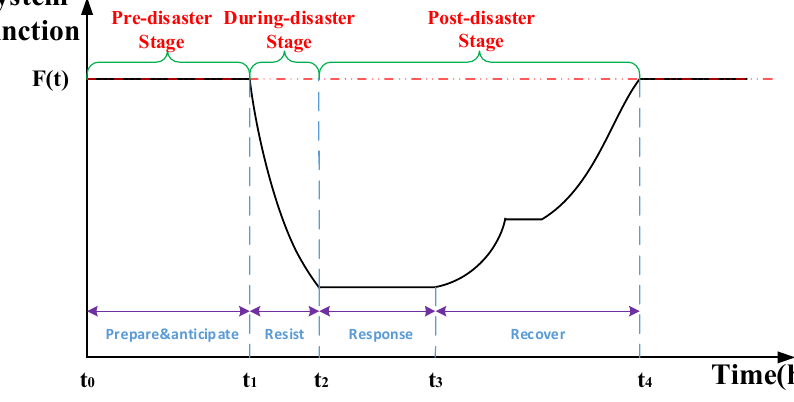
Figure 1. The illustrative process of a resilient power system under disasters.